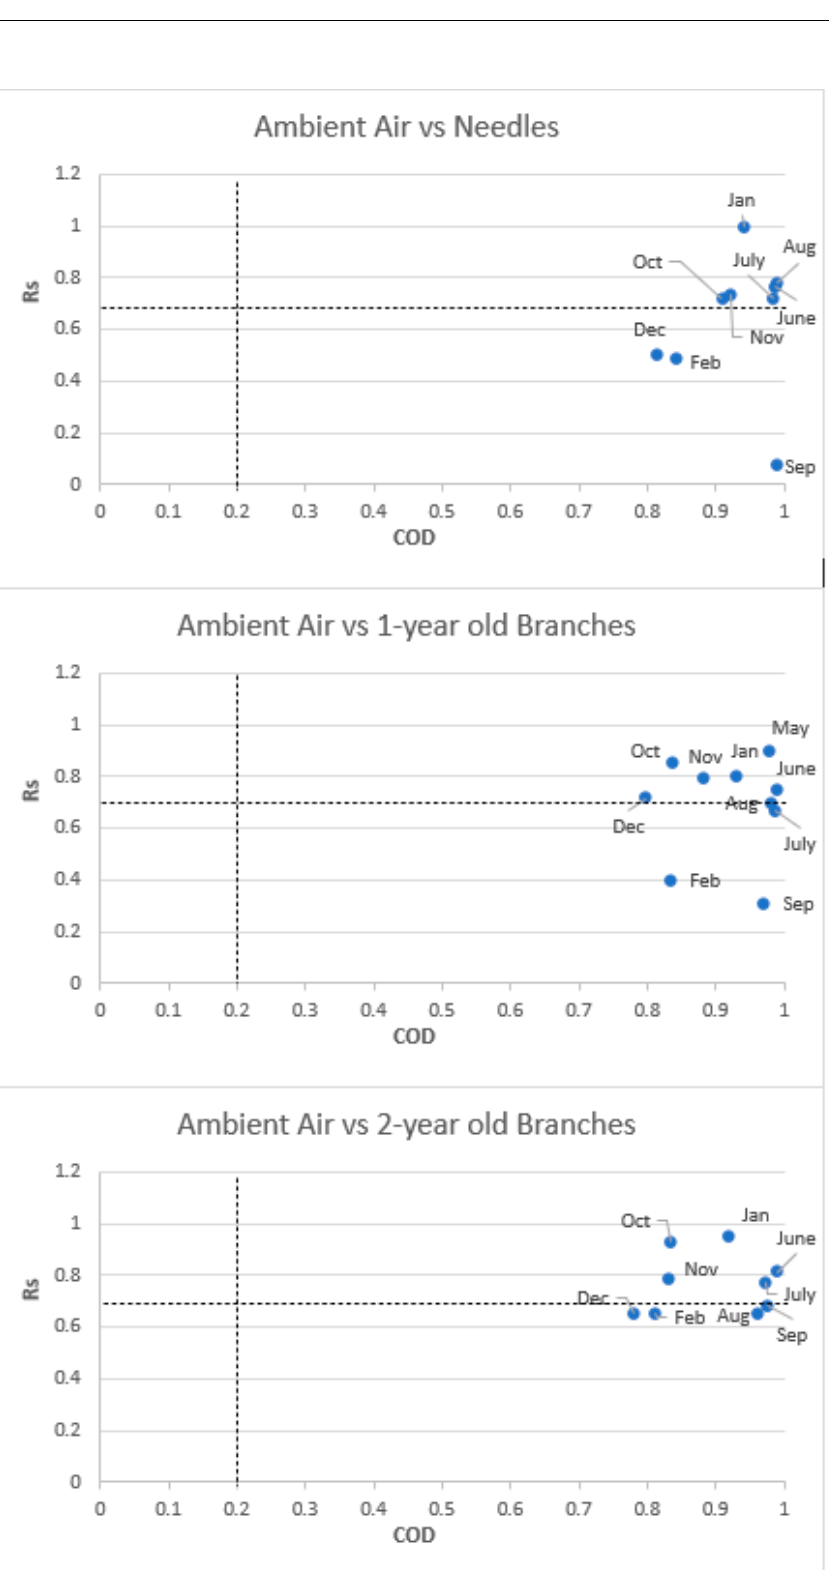
Figure 2. Correlation coefficient (R s ) and coefficient of divergence (COD) values of PAHs for the ambient air vs. tree components.